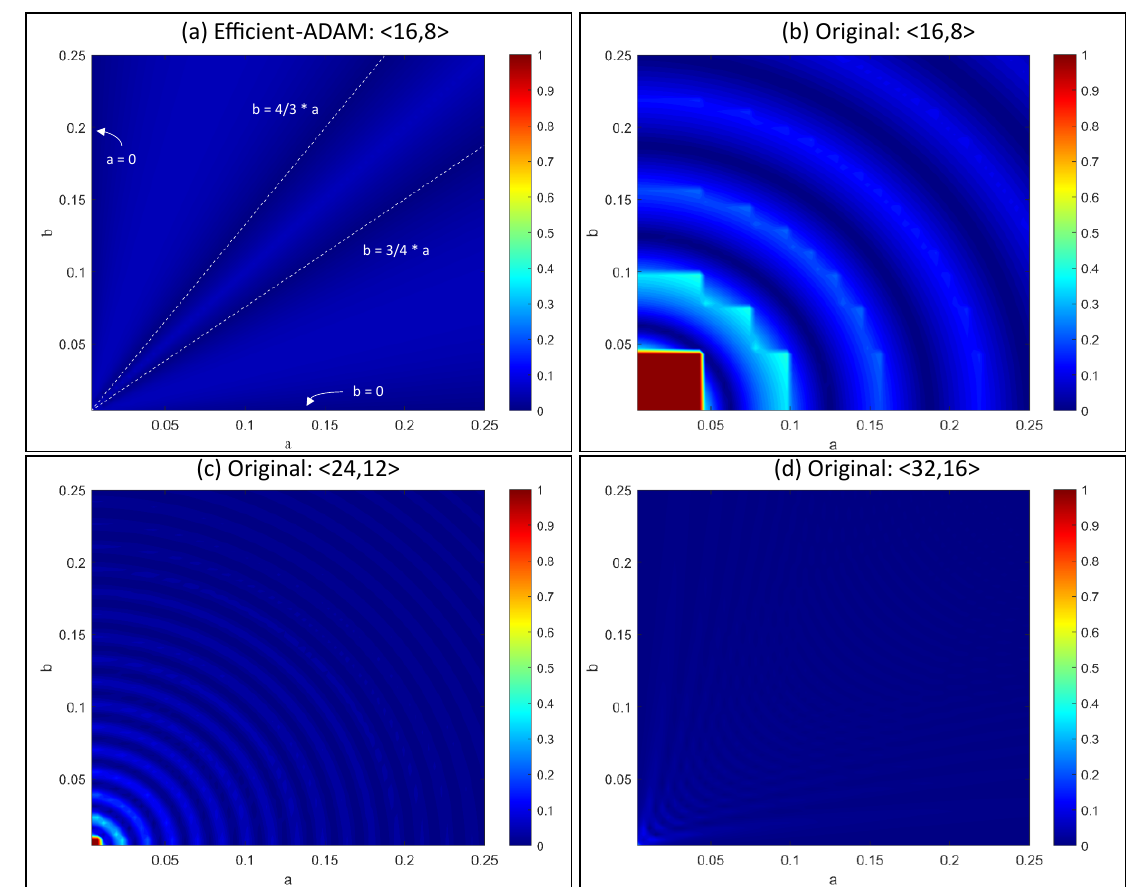
Figure 7. The accuracy of the proposed approximation to the second moment estimation. The √ a 2 + b 2 . Subgraph ( a ) is the relative error of E-ADAM with the (cid:104) 16,8 (cid:105) fixed-point calculation is number. Four cases where the relative error is 0 are illustrated. Subgraph ( b ) is the relative error of the original ADAM with the (cid:104) 16,8 (cid:105) fixed-point number. Subgraph ( c ) is the relative error of the original ADAM with the (cid:104) 24,12 (cid:105) fixed-point number. Subgraph ( d ) is the relative error of the original ADAM with the (cid:104) 32,16 (cid:105) fixed-point